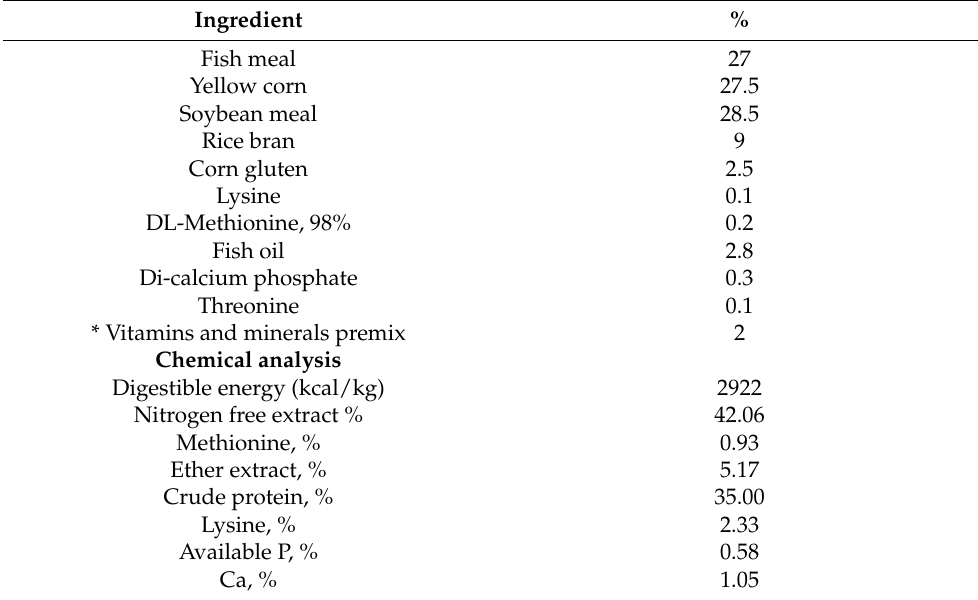
Table 1. The basal diet ingredients and chemical